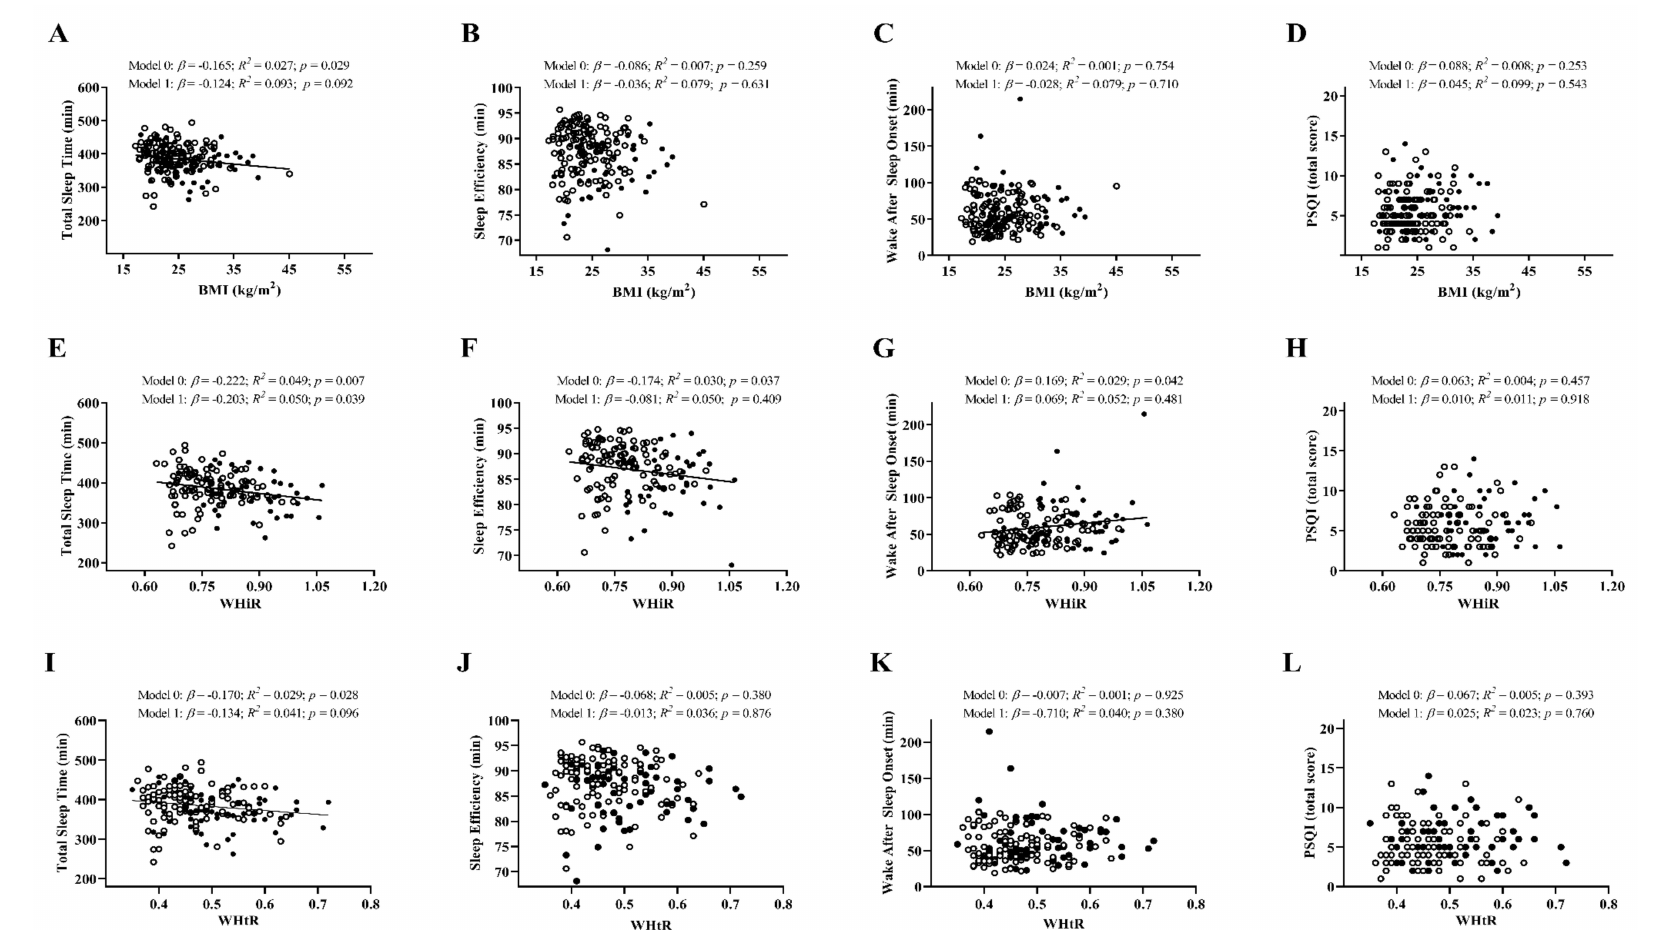
Figure 1. Linear regression graphs of body mass index (BMI), waist–hip ratio (WHiR), and waist–height ratio (WHtR) with total sleep time (Panels ( A , E , I )), sleep e ffi ciency (Panels ( B , F , J )), wake after sleep onset (Panels ( C , G , K )), and PSQI total score (Panels D , H , L )), before and after adjusting by sex (model 0 and model 1, respectively). β , standardized linear regression coe ffi cient; R 2 , coe ffi cient of determination; p , p -value. Closed and open circles represent men and women, respectively. Abbreviations: BMI, body mass index; WHiR, waist–hip ratio; WHtR, waist–height ratio; PSQI, Pittsburgh sleep quality